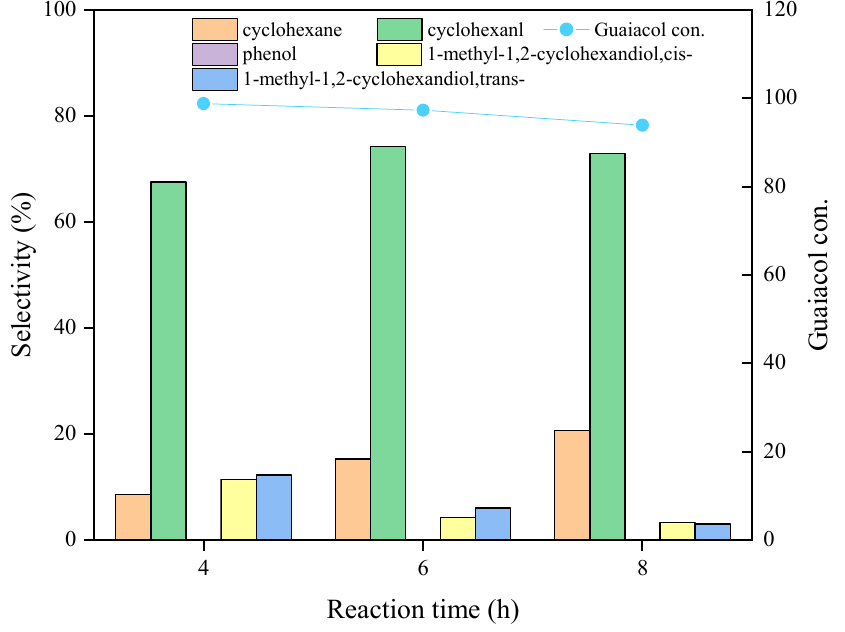
Figure 7. Guaiacol conversion and product distribution at different reaction times. Reaction condi- tions: Ni3Mo1@C catalyst, T = 240 °C, and p = 2 MPa.